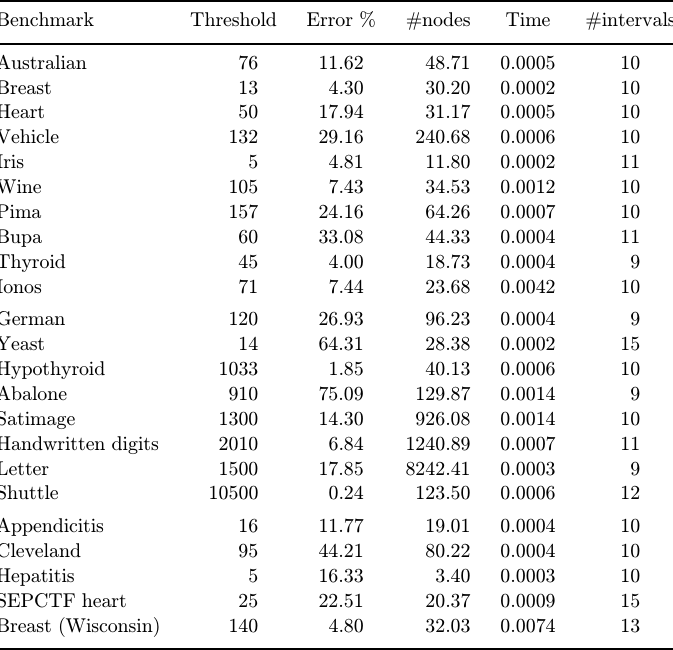
Table 2. Numerical results of ULR-Discr using (cid:1) 2